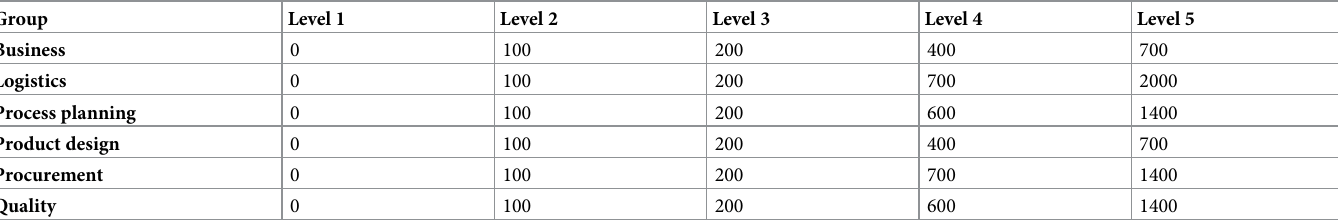
Table 1. Post functional level